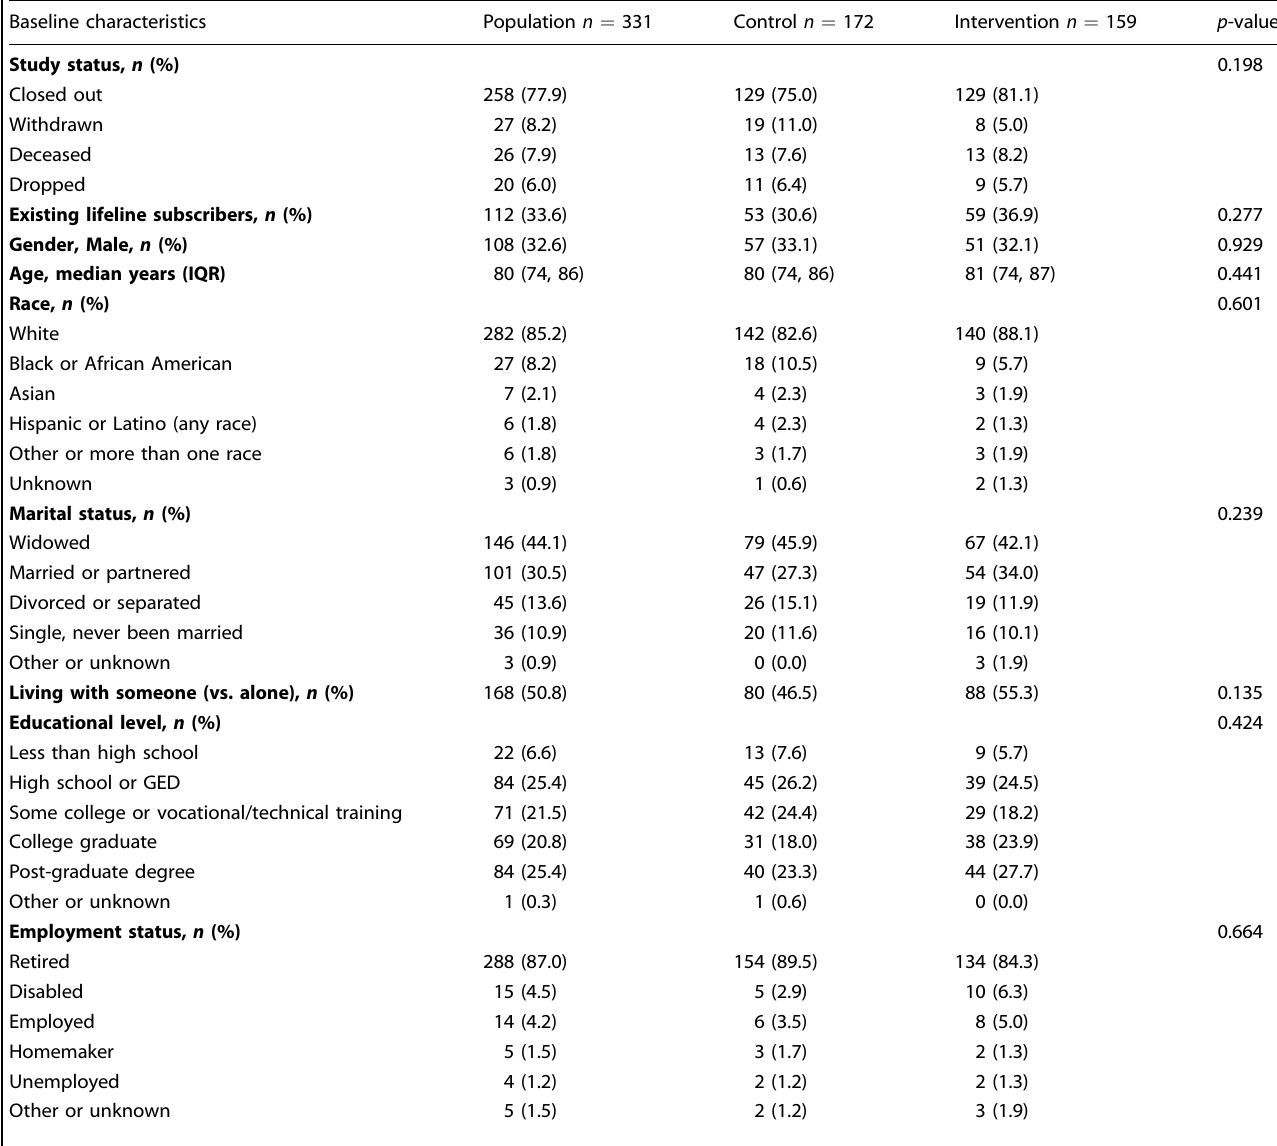
Table 1. Baseline characteristics by group —